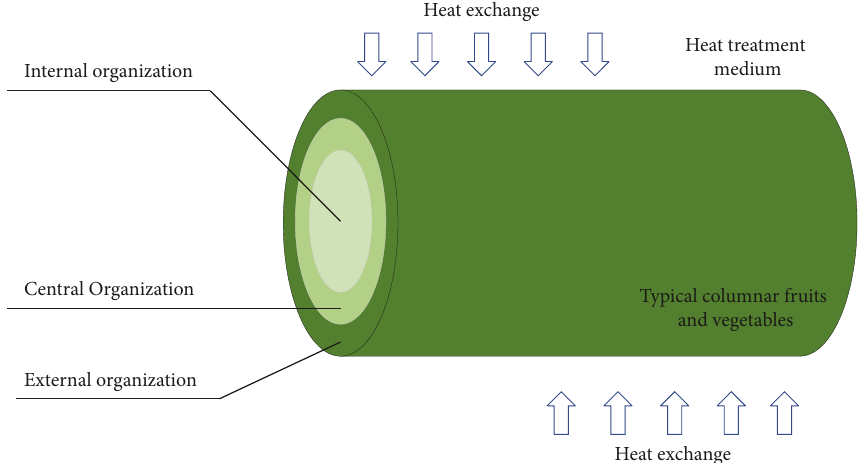
Figure 2: Multilayer physical model of columnar fruits and vegetables.